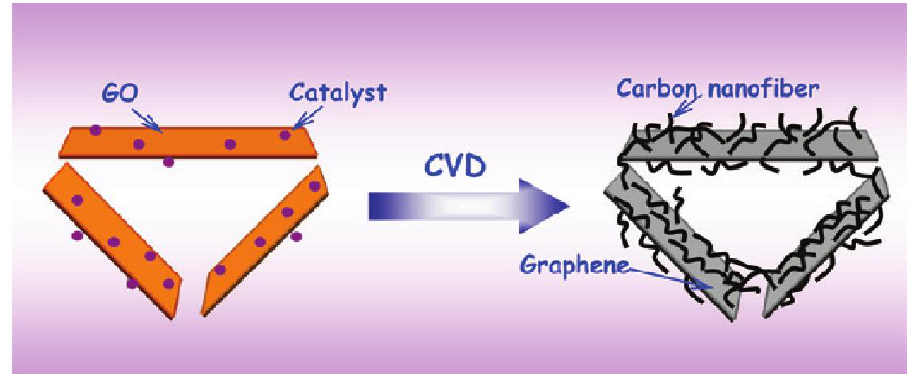
Figure 14. Schematic illustration of the structure with 1D CNF grown on 2D graphene nanosheets